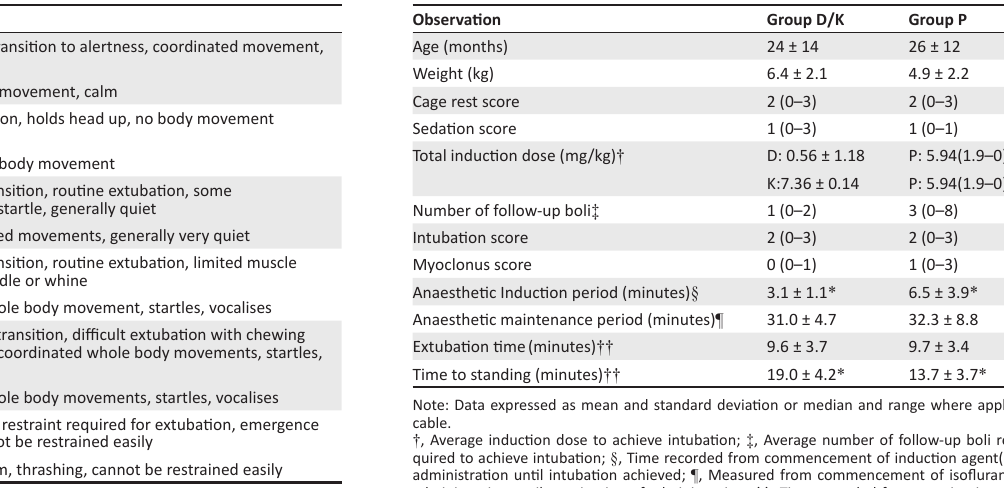
TABLE 2: Scoring system used for quality of recovery † from anaesthesia in dogs induced with either diazepam-ketamine or propofol and maintained on isoflurane.